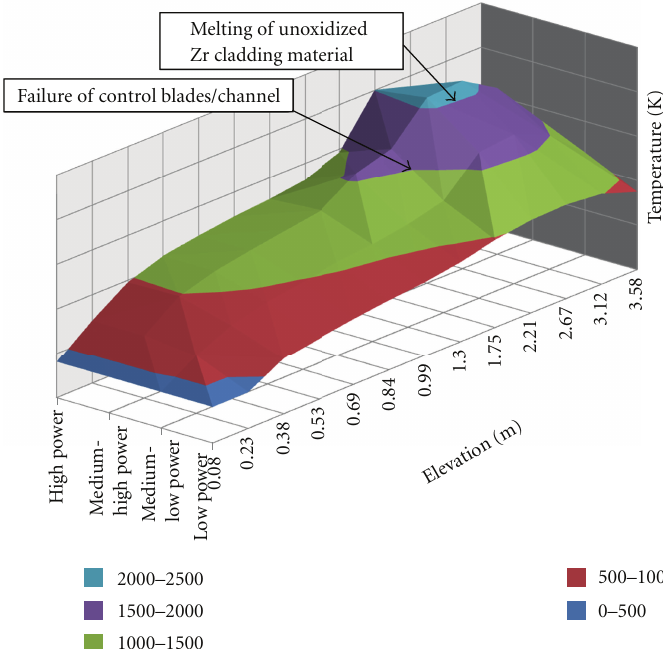
Figure 12: Core temperature distribution at 5.0 hours after reactor scram for a scenario with depressurization and termination of emergency water injection at 4.2 hours after reactor scram (CRD flows